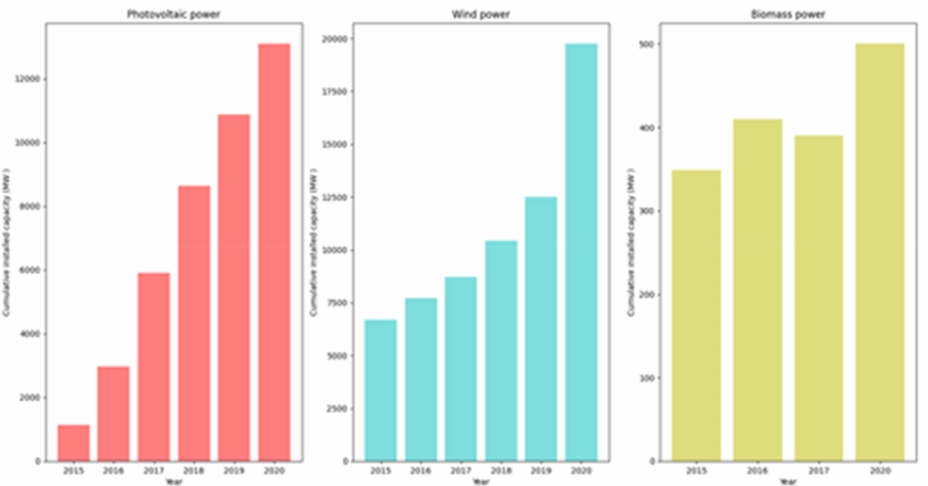
Figure 3. The cumulative installed capacity of photovoltaic power, wind power, and biomass power in Shanxi Province from 2015 to